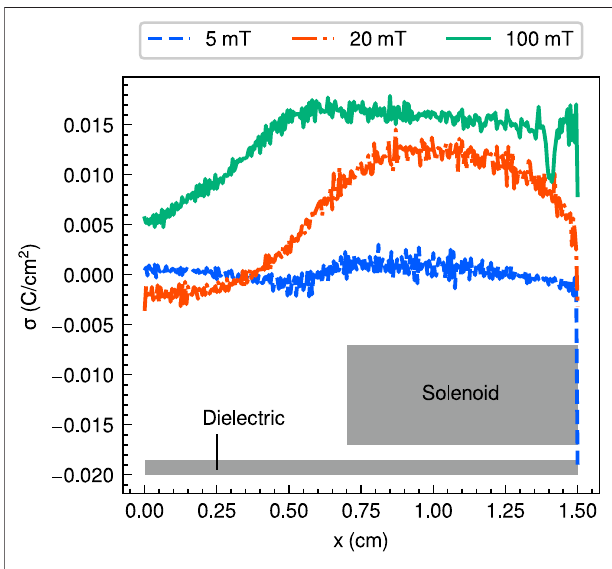
FIGURE 6 | x pro fi les of the surface charge density on the lateral dielectric wall σ for the three magnetic fi eld strengths of 5 (a dashed blue line), 20 (a dotted-dashed orange line), and 100 mT (a solid green line). Gray boxes show locations of the solenoid and the lateral dielectric